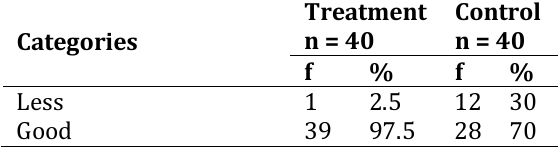
Table 8. Effect of Health Education on Prevention